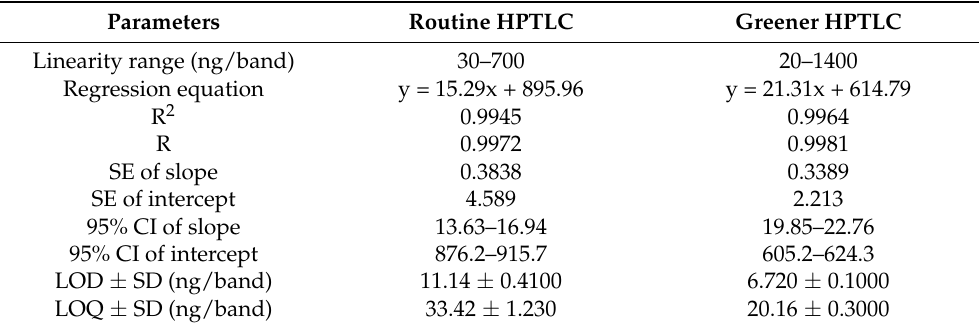
Table 2. Results for the linear regression analysis of GFT for the routine and greener HPTLC methods (mean ± SD; n = 6).